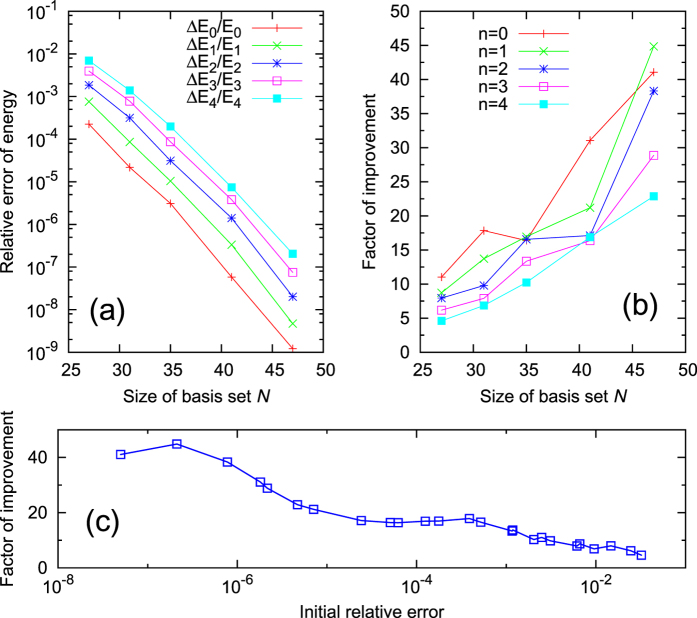
Same asFig. 3
but for a Morse potential. No linear fit is performed for the data points in (c).